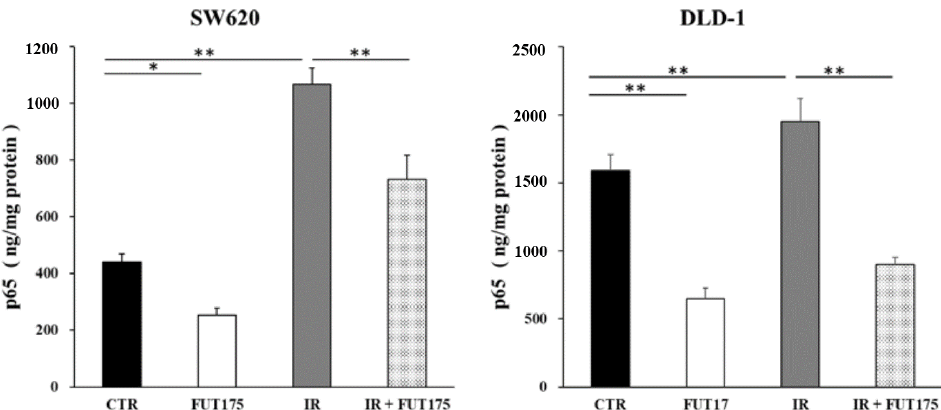
Figure 1. Inhibition of ionizing radiation (IR)-induced activation of nuclear factor kappa B (NF- κ B) by nafamostat mesilate (FUT175). Assessment of NF- κ B activation (p65 levels) in SW620 and DLD-1 cells by enzyme-linked immunosorbent assay (ELISA). The cells were treated with FUT175 (80 µ g/mL) for 3 h prior to irradiation (5 Gy). At 3 h of incubation after the treatment, the levels of NF- κ B p65 in the nuclear extracts were measured. p65 concentration was higher in the IR groups than in the control groups (SW620: 1169.4% ± 158.2 vs. 903.3% ± 93.1, DLD-1: 1948.5% ± 169.8 vs. 1589.2% ± 115.7; p < 0.01) and decreased in the combination groups (SW620: 447.5% ± 72.2, DLD-1: 899.6% ± 53.7; p < 0.01). *, p < 0.05; **, p < 0.01. All experiments were performed in triplicate.